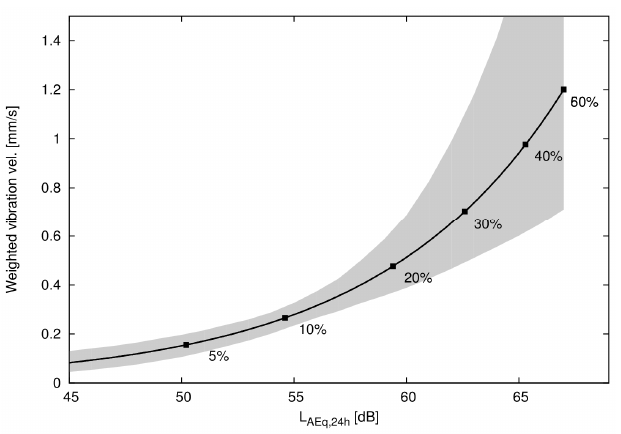
Figure 6. Function of equal annoyance with 95% confidence intervals estimated using bootstrapping (BC a ). Labels indicate percentage of annoyed by vibration or noise. (BC a ). Labels indicate percentage of annoyed by vibration or